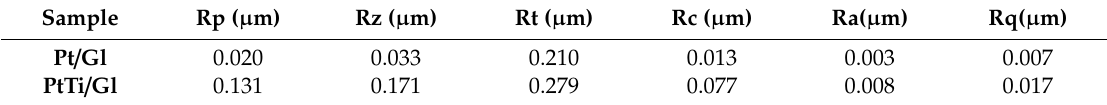
Table 4. The roughness parameters of the samples.